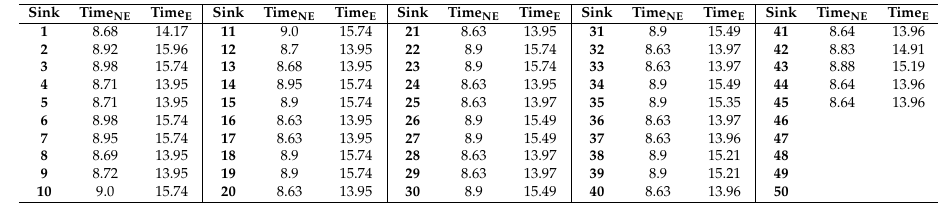
Table A13. Scenario 3: transmission times (in s) for each sink all over the transmission line. (Distance between poles is equal to 300 m, κ = 12, η = 2, NE means no encryption, E means encryption.)